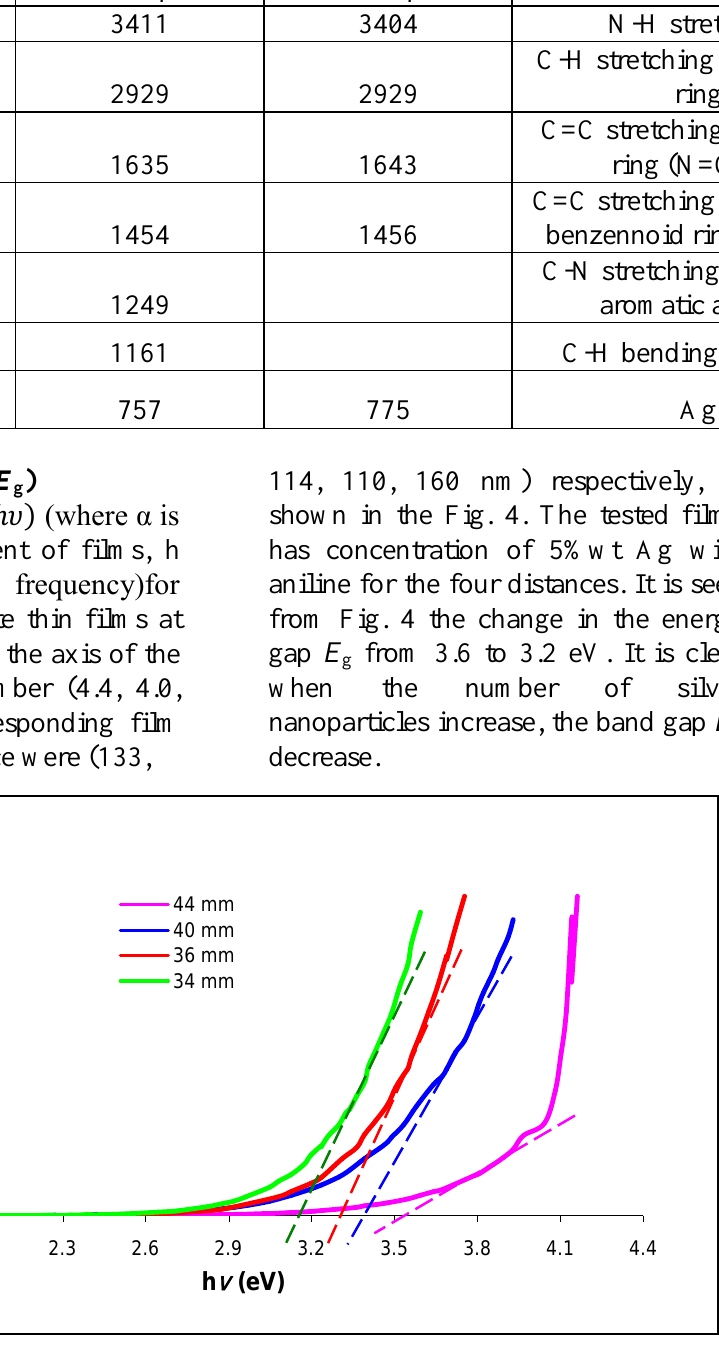
) of the Ag/PAIN nanocomposite thin 𝜈𝜈